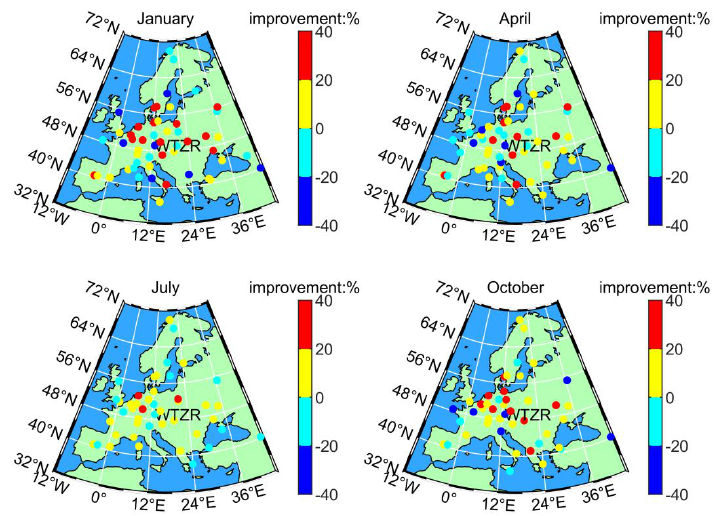
Figure 11. Distribution of improvement rate of all available stations from Scheme 3 in January, April, July, and October of 2018. Red spots refer to the improvement rate of the available IGS stations in the range of 0–20%, 20%–40% for yellow spots, − 20%–0 for cyan spots, and − 40%– − 20% for blue spots.